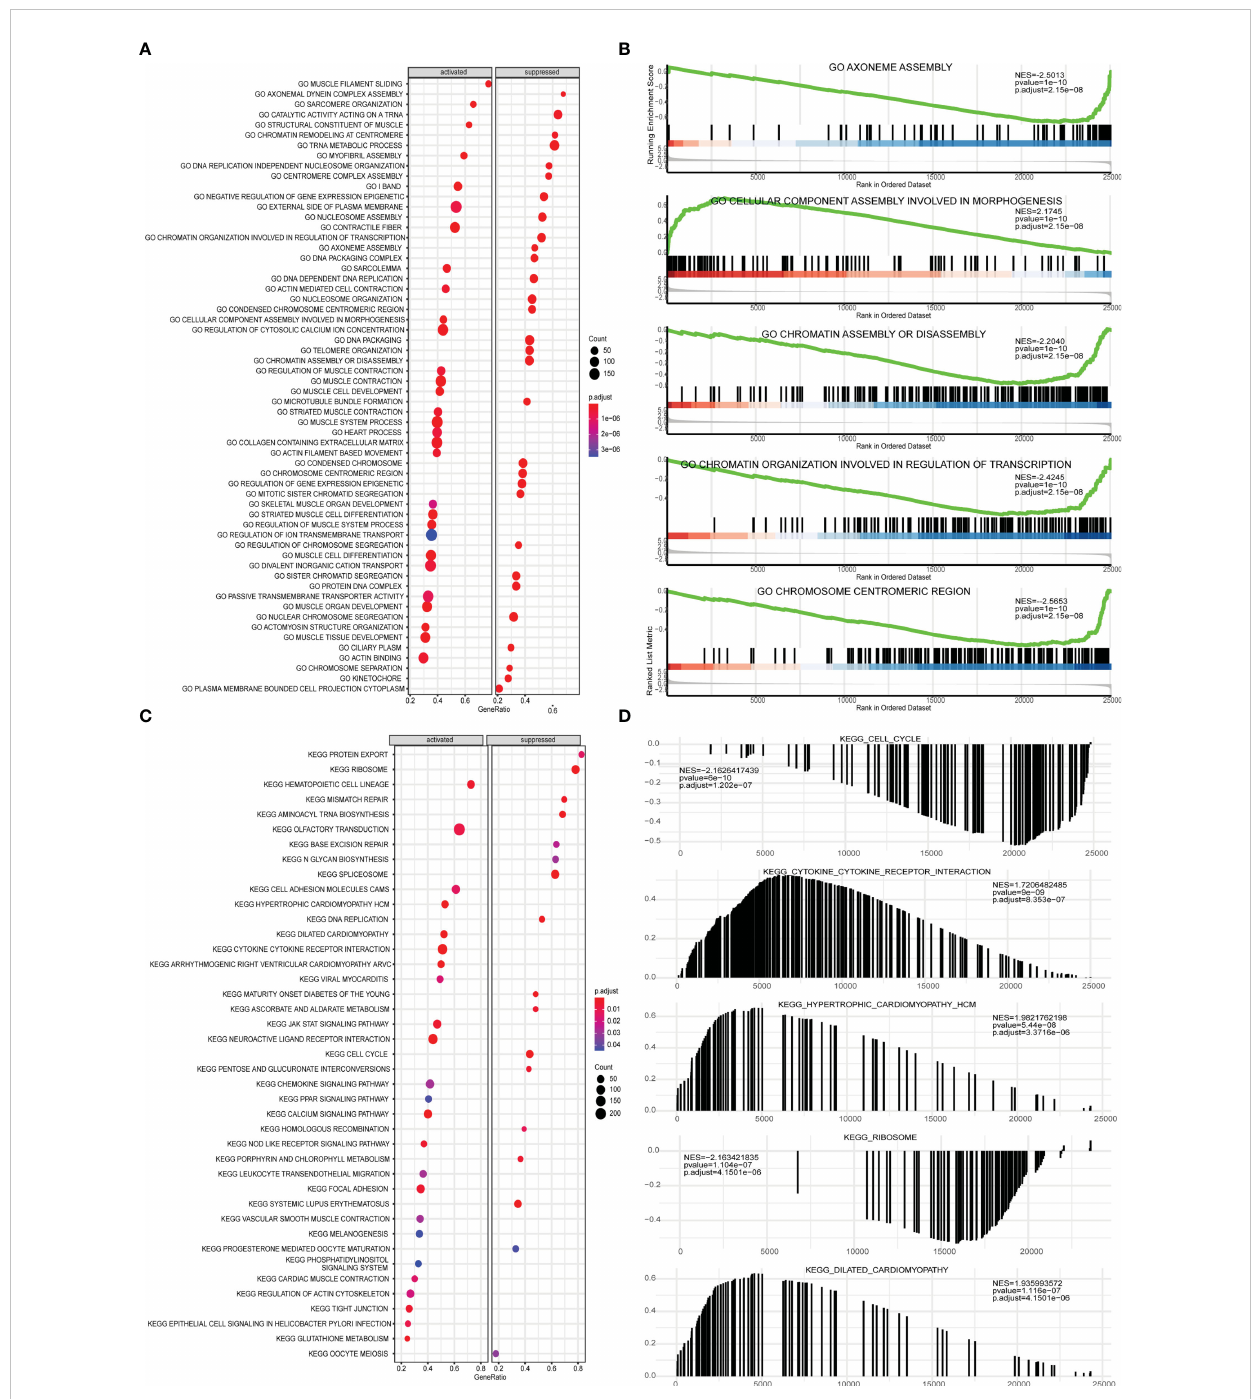
FIGURE 10 GSEA analysis of high-risk group and low-risk group. (A) GSEA-GO analysis of a dataset of PRAD patients from TCGA, the horizontal axis is the gene ratio, the vertical axis is the GO terms, and the color represents -log10 (p value). (B) The fi rst 5 items of the GSEA-GO analysis of the entire dataset of PRAD patients from TCGA are shown. (C) GSEA-KEGG analysis of dataset of PRAD patients from TCGA, the horizontal axis is the gene ratio, the vertical axis is the GO terms, the node size represents the number of genes enriched in GO terms, and the node color represents log10 (p value). (D) The fi rst 5 items of the GSEA-KEGG analysis of dataset of PRAD patients from